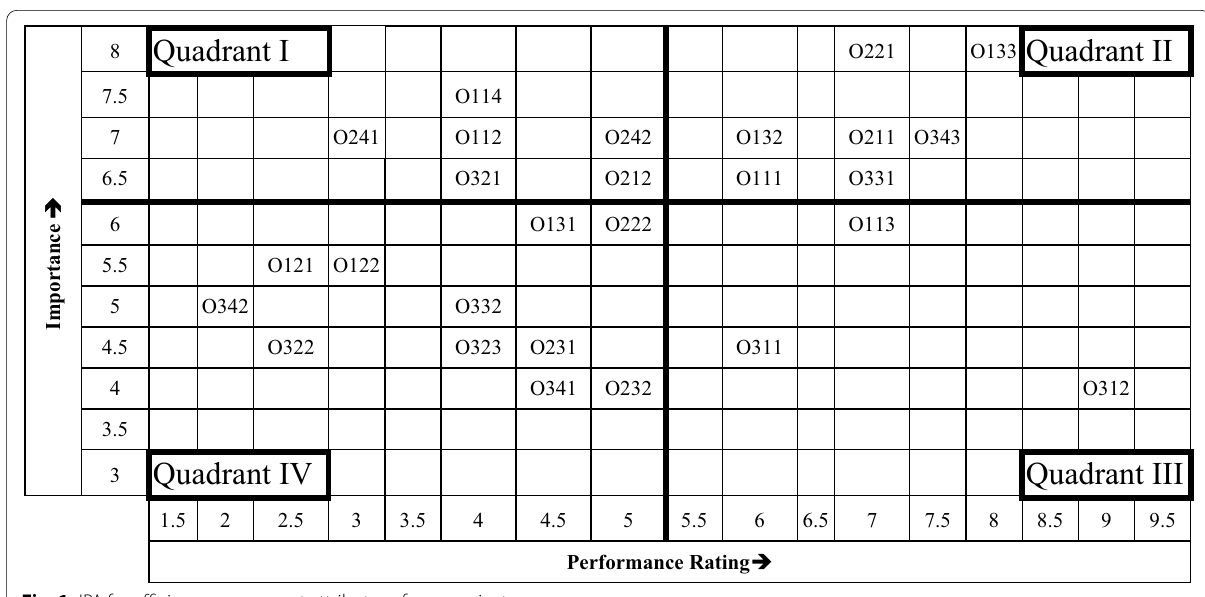
Fig. 1 IPA for efficiency assessment attributes of case